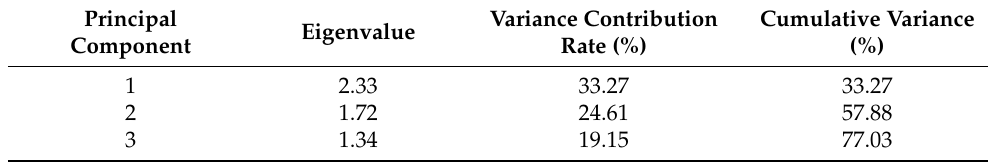
Table 1. Eigenvalues, variances, and cumulative variances.